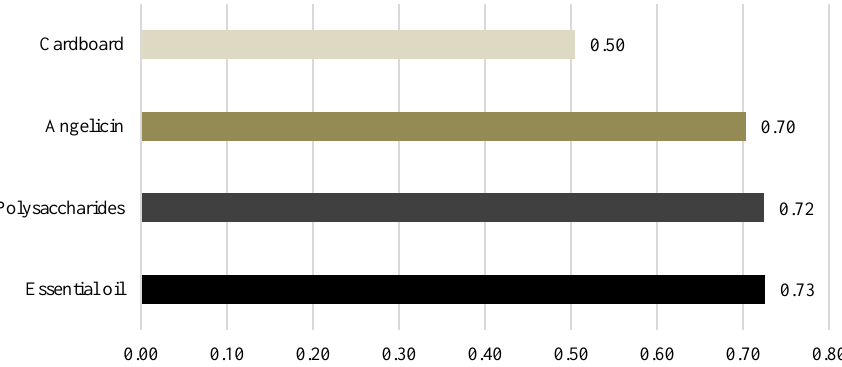
Fig. 6. Multicriteria analysis results for four selected